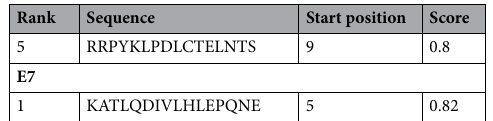
Table 6. B Cell epitopes of L1, E5, E6, & E7 proteins of HPV 18.